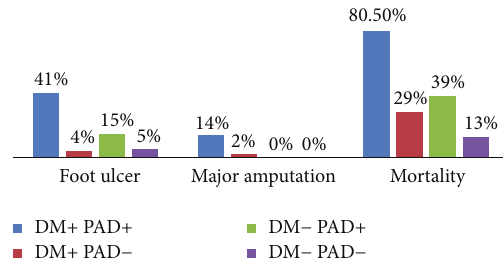
Figure 3: Outcomes in HD patients based on the presence/absence of DM and/or PAD ( 𝑃 = 0.001 for all).